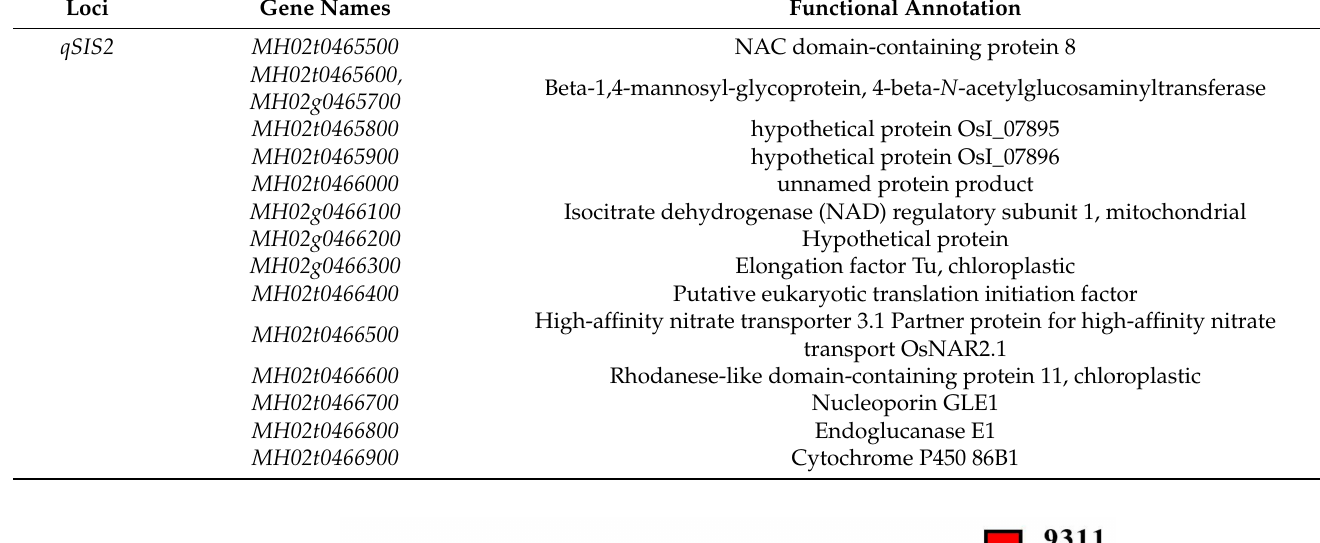
Table 2. The predicted functional genes at the loci of qSIS2/qWCSST2/qRWCS2 .